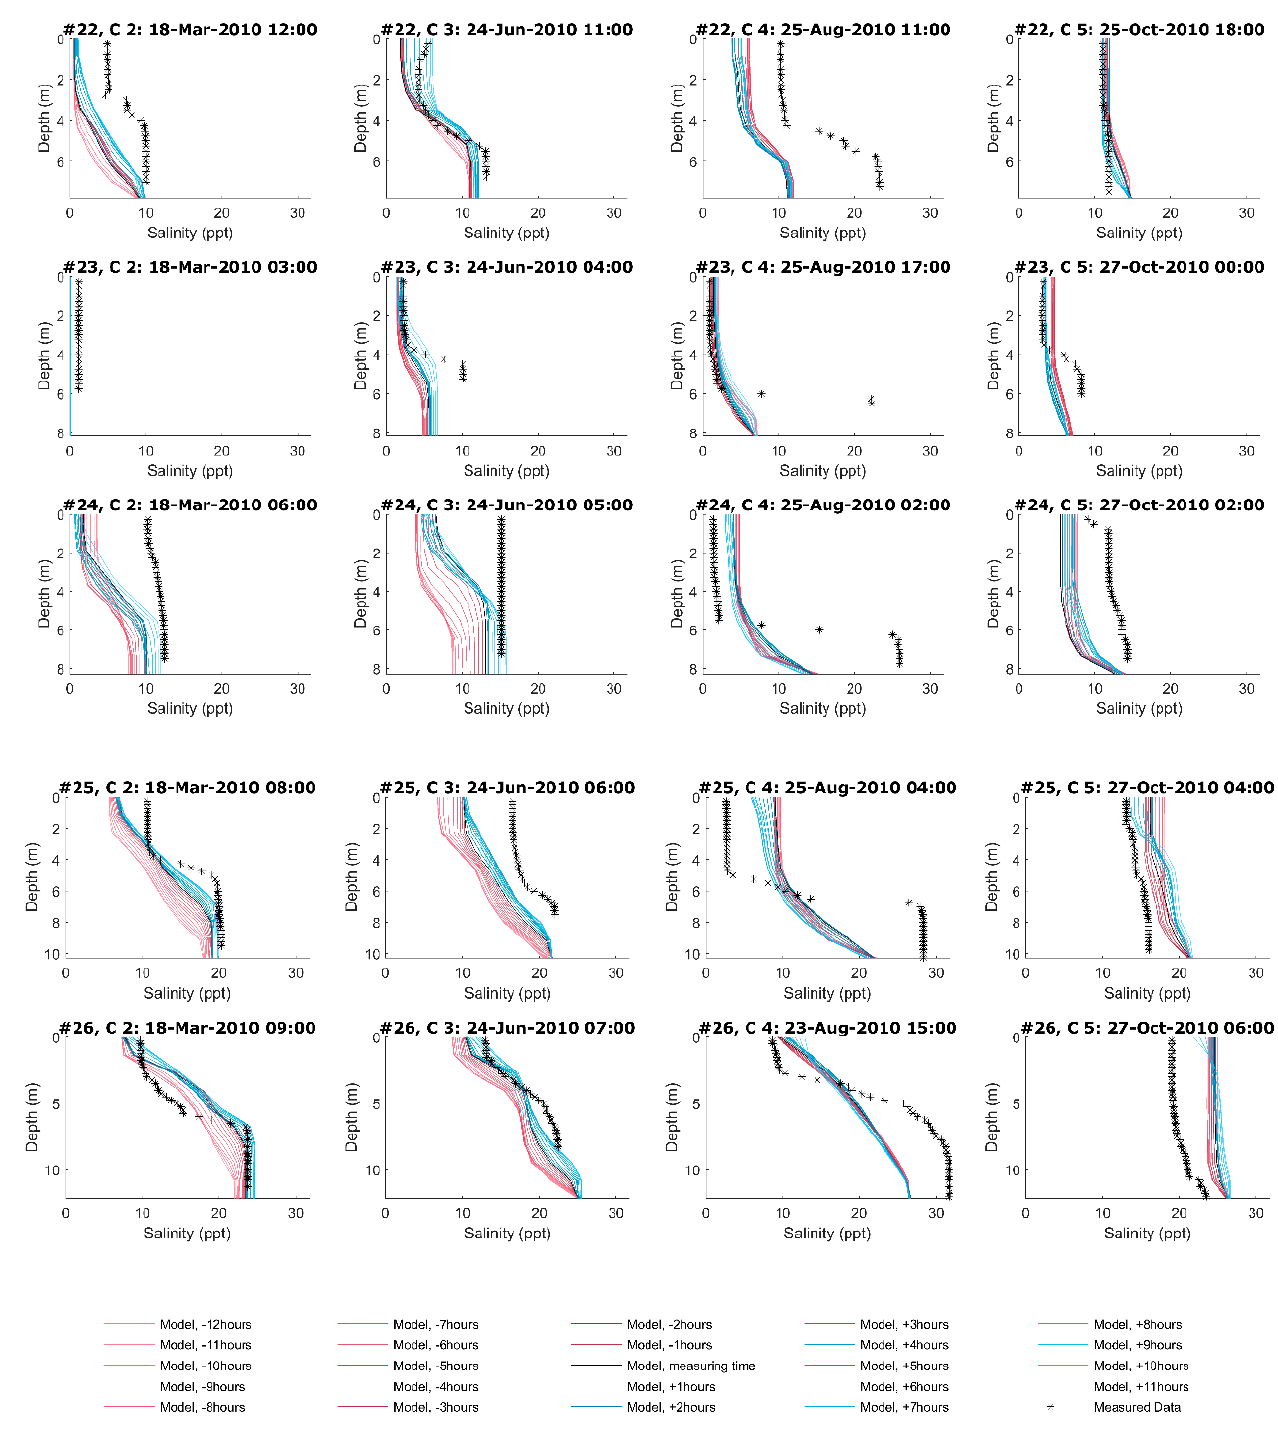
Figure 2. Vertical salinity profiles (stations 16–26) measured during the IFREMER surveys in March, June, August, and October 2010, as well as vertical salinity profiles obtained hourly with the RPtide model for each survey at each station from 12 h prior to 12 h after the measured time.